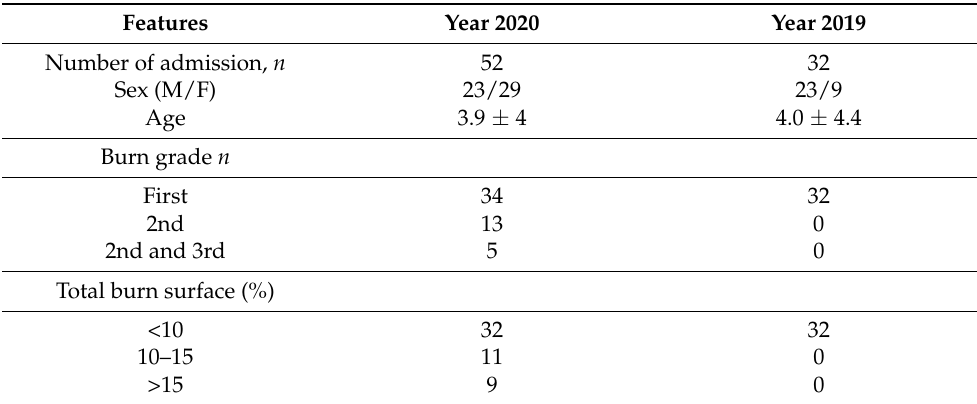
Table 1. Features of the patients admitted to Emergency Unit in February to December 2020 and in the same period in the previous year